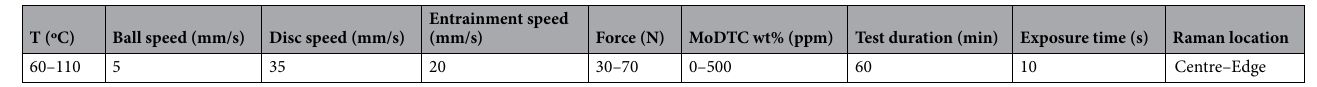
Table 2. Range investigated for each experimental test